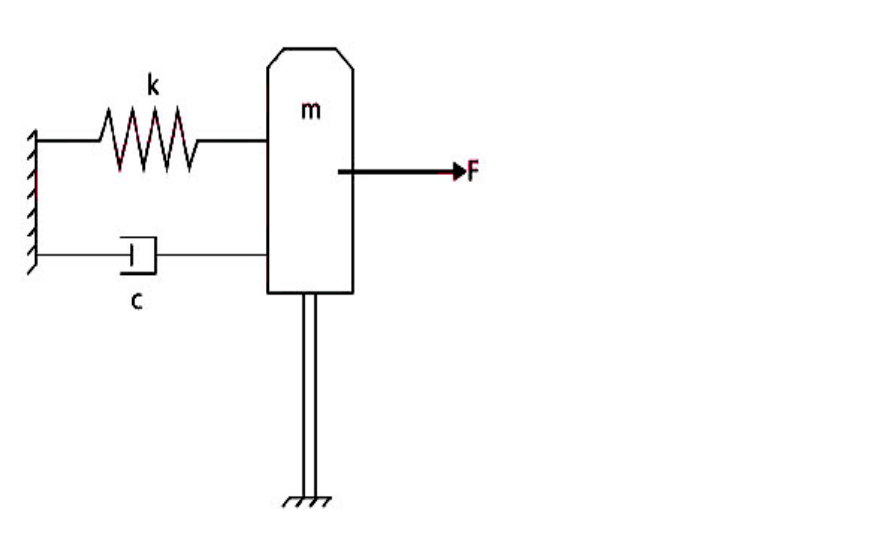
Figure 3. The simplified vibrational system of VBT.